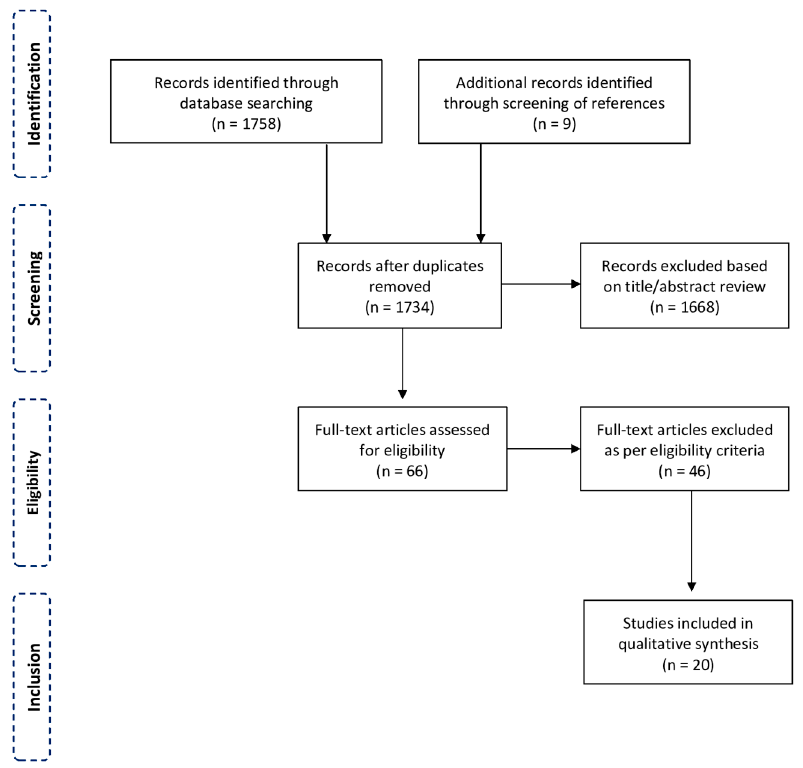
Figure 1. Flowchart showing the methodology of the systematic review.